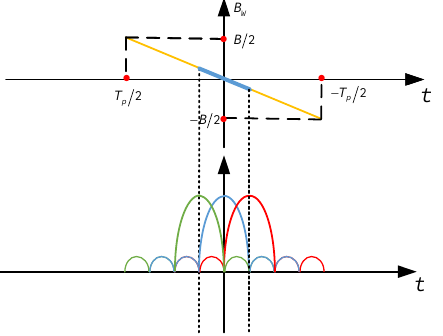
Figure 3. Sketch of equivalent transmit beampattern and the time-frequency relationship of LFM signal.